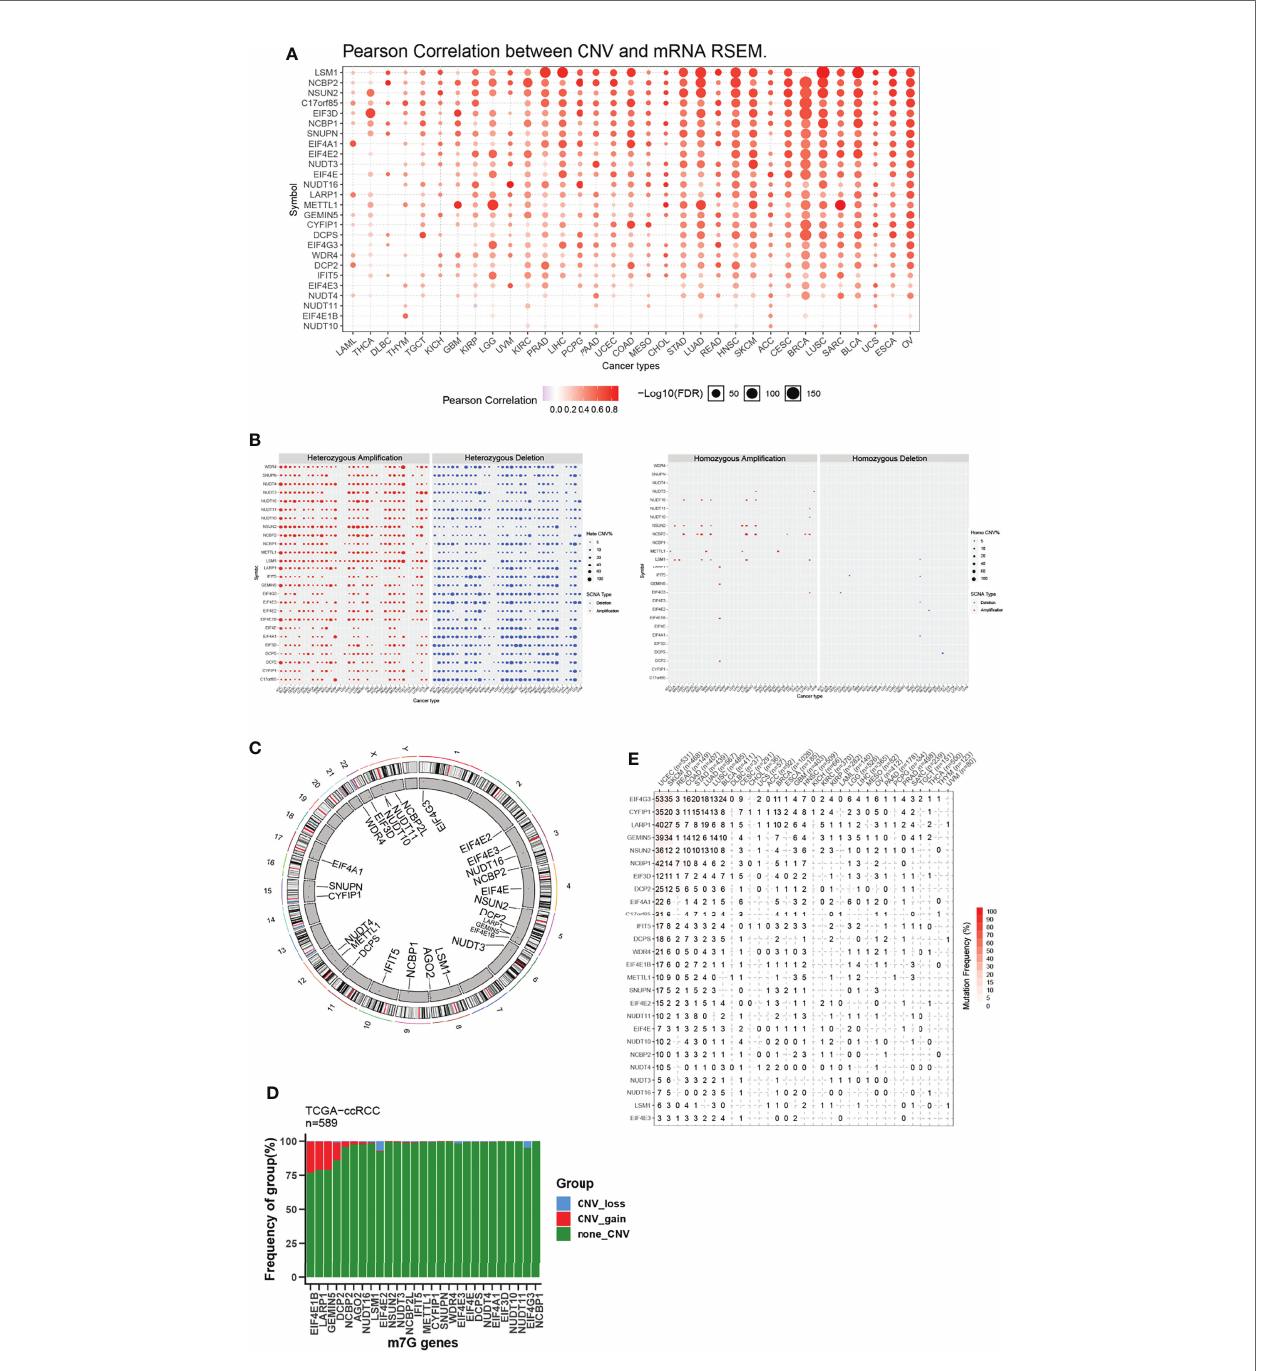
FIGURE 1 | CNV and sequence alteration contribute to abnormal m 7 G-Regulator Levels. (A) CNV strongly correlates to gene expression of m 7 G regulators in pan- cancer using Pearson analysis. (B) Heterozygous and homozygous ampli fi cation/deletion of m 7 G regulators in pan-cancer. Ampli fi cation, red; Deletion, blue. (C) The location of CNV of m 7 G regulators on 23 chromosomes. (D) CNV of m 7 G regulators in TCGA-ccRCC dataset. CNV loss, blue; CNV gain, red; none CNV, green. (E) Mutation frequency of m 7 G regulators in